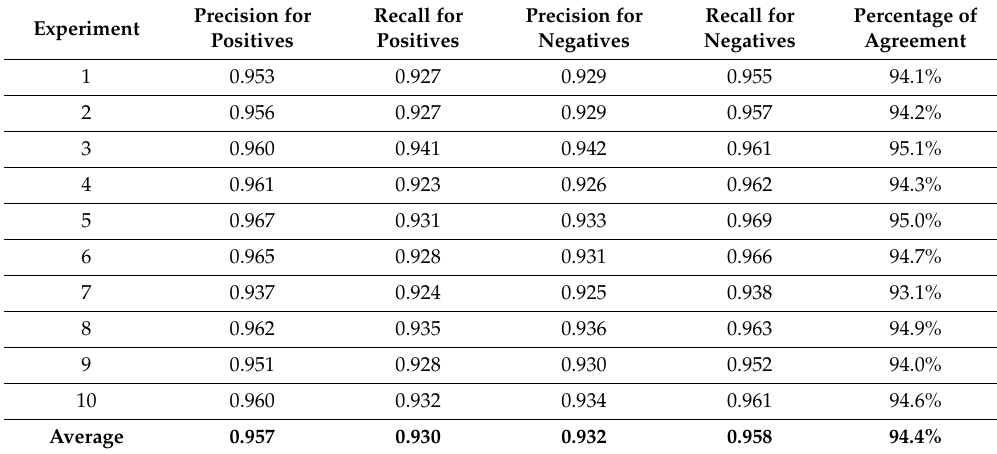
Table 4. Results of the classifiers obtained with a multilayer